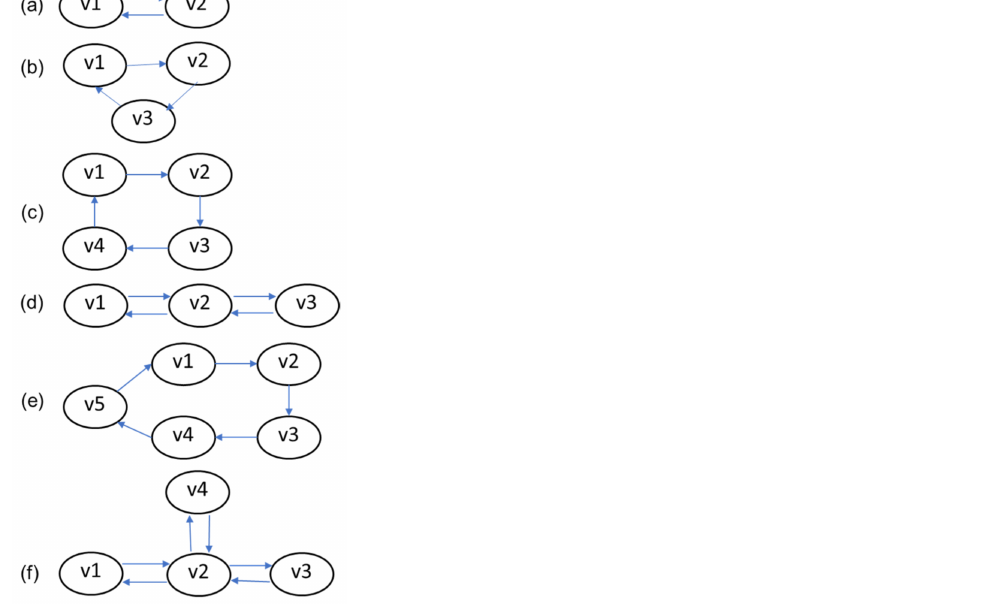
Figure 3. Six SCC subgraphs to be detected from graph dataset: ( a ) g1, ( b ) g2, ( c ) g3, ( d ) g4, ( e ) g5, ( f )